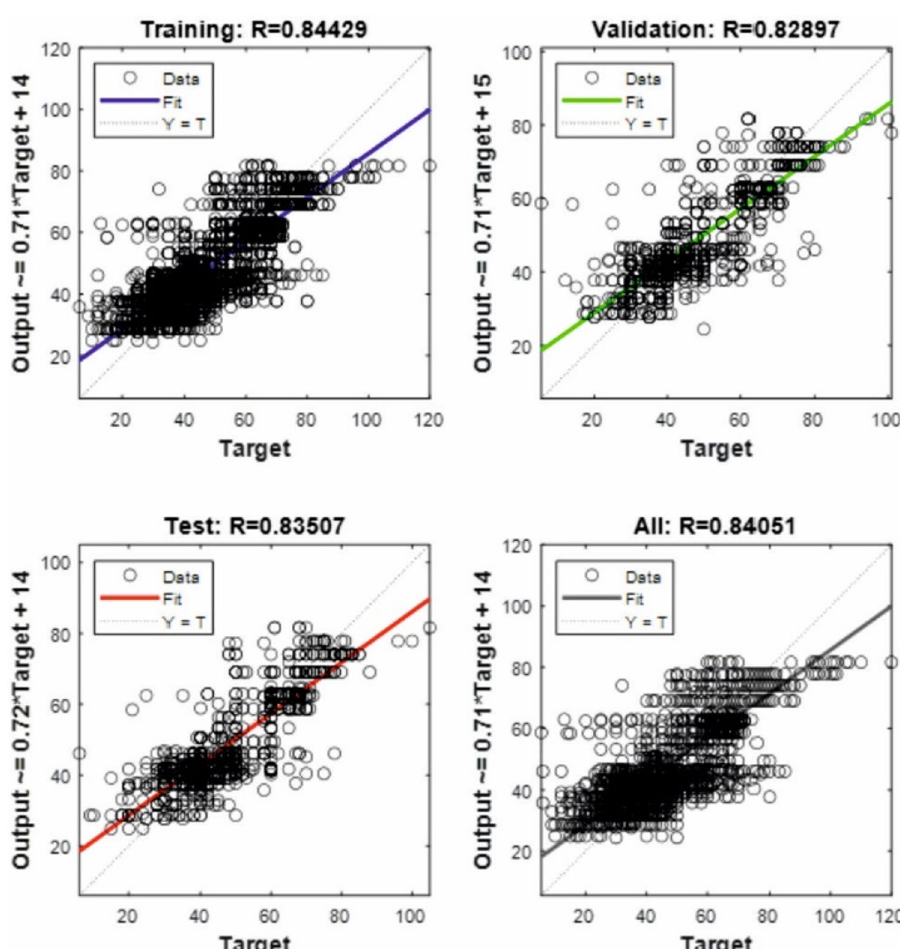
Fig. 9 Cross-correlations between the predicted (out- put) and the measured (target) ROP values for model